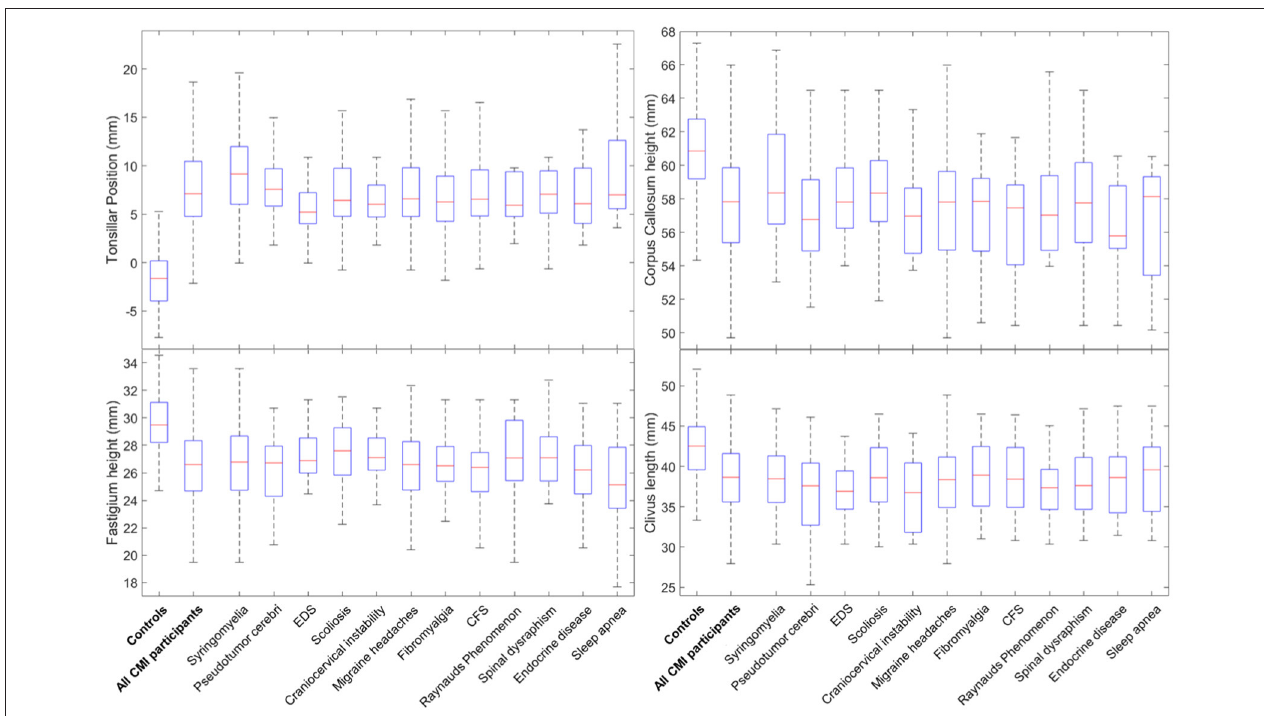
FIGURE 2 | Boxplots for group differences between 12 PCs and controls for tonsillar position, fastigium heights, corpus callosum height, and clivus length. Horizontal lines within boxes represent group median, boxes represent the 25th and 75th percentile rank of group values.